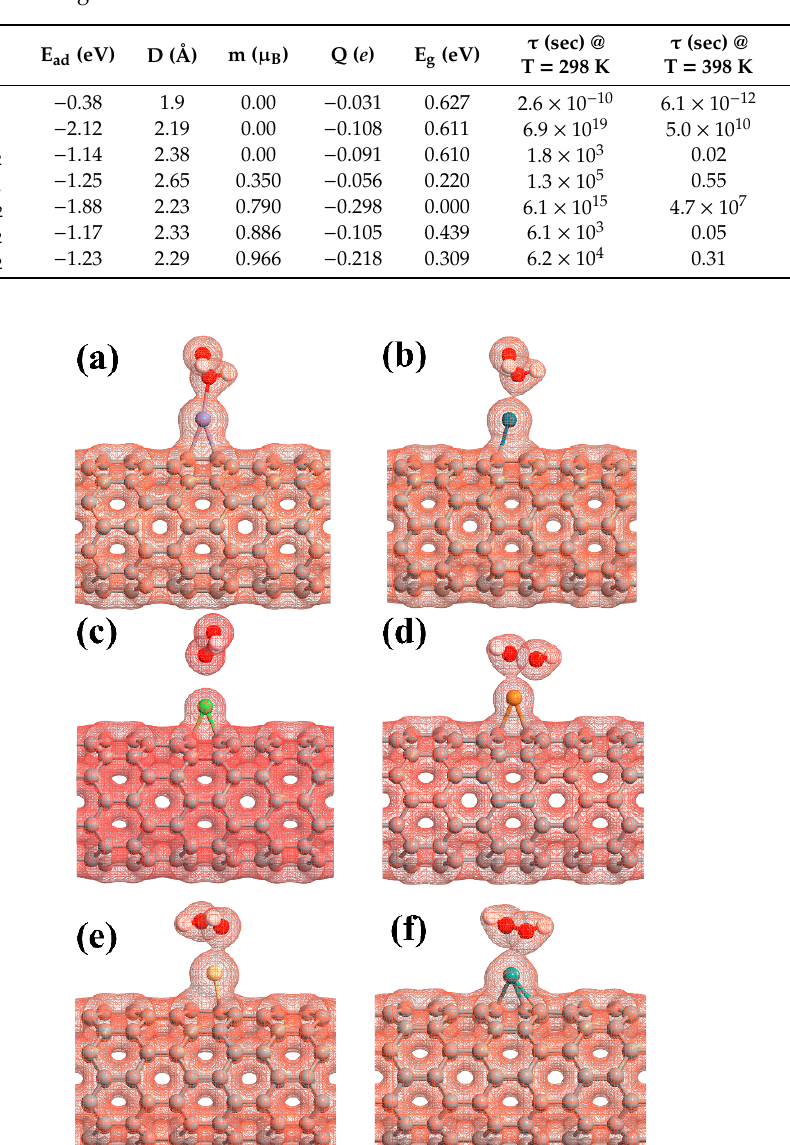
Table 3. The calculated adsorption energy (E ad ), binding distance (D), which is the distance between H 2 O 2 molecule and the metal in the metal-decorated CNT structure or the shortest distance between the H 2 O 2 molecule and the nanotube in the pristine CNT structure, magnetic moment (m), charge transfer (Q), energy bandgap (E g ), and recovery time ( τ ) at T = 298 and 398 K under UV. The negative values of charge indicate a charge transfer from the molecule to the nanotube.